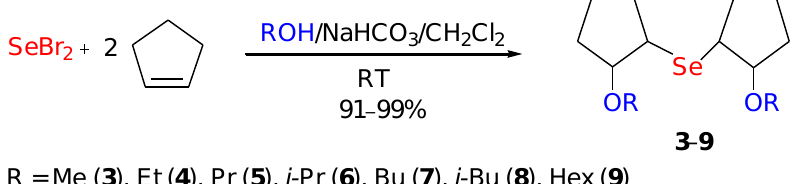
Scheme 3. The synthesis of bis(2-alkoxycyclopentyl) selenides 3 – 9 from selenium dibromide, cy- clopentene, and alcohols.